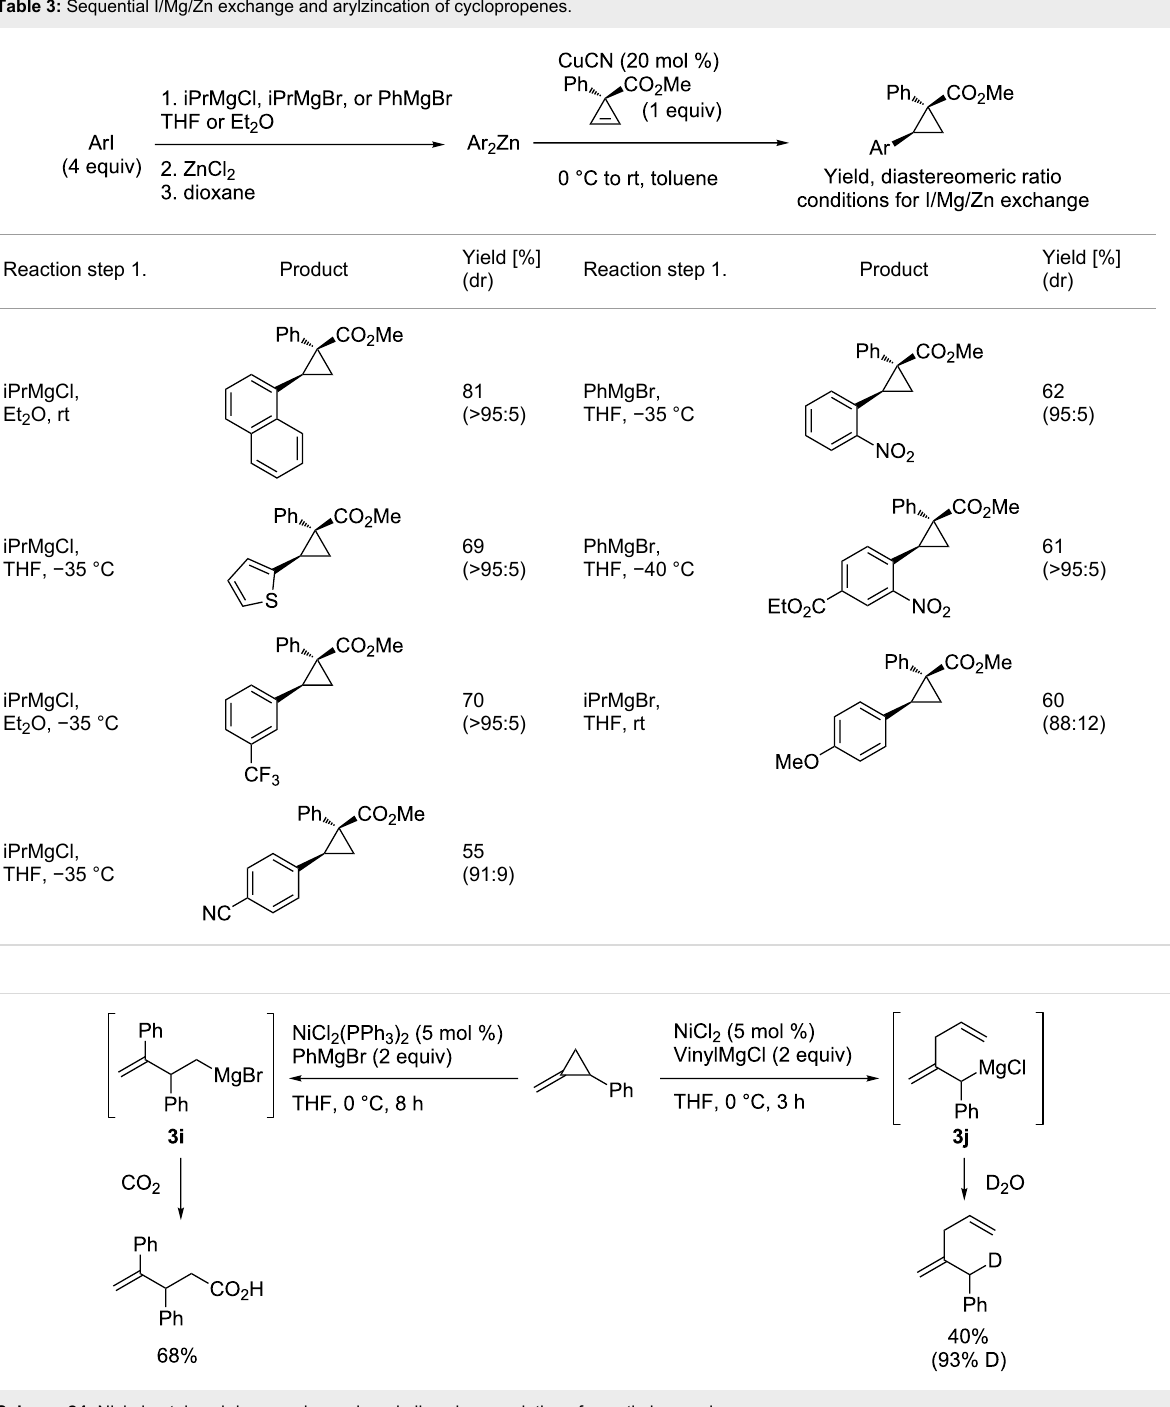
Table 3: Sequential I/Mg/Zn exchange and arylzincation of cyclopropenes.